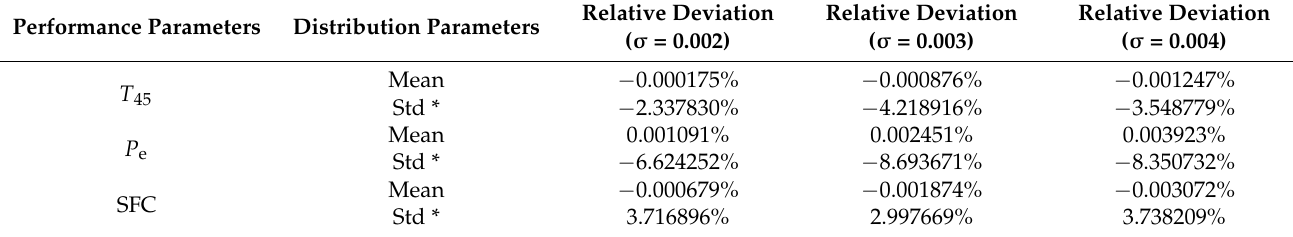
Table 5. The relative deviations between the two scenarios for three PMs under different standard deviations of the uncertain